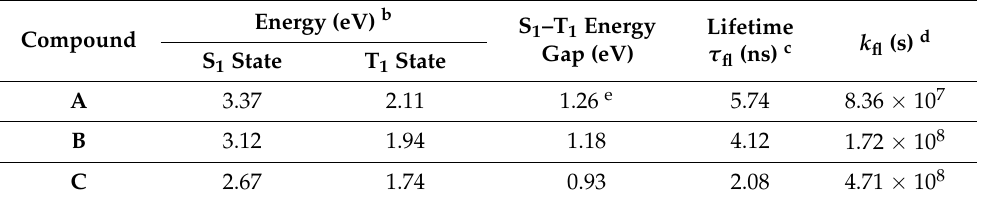
Table 3. DFT computational studies on singlet and triplet excited states a , lifetimes, and fluorescence rate constant k fl for compounds A , B , and C